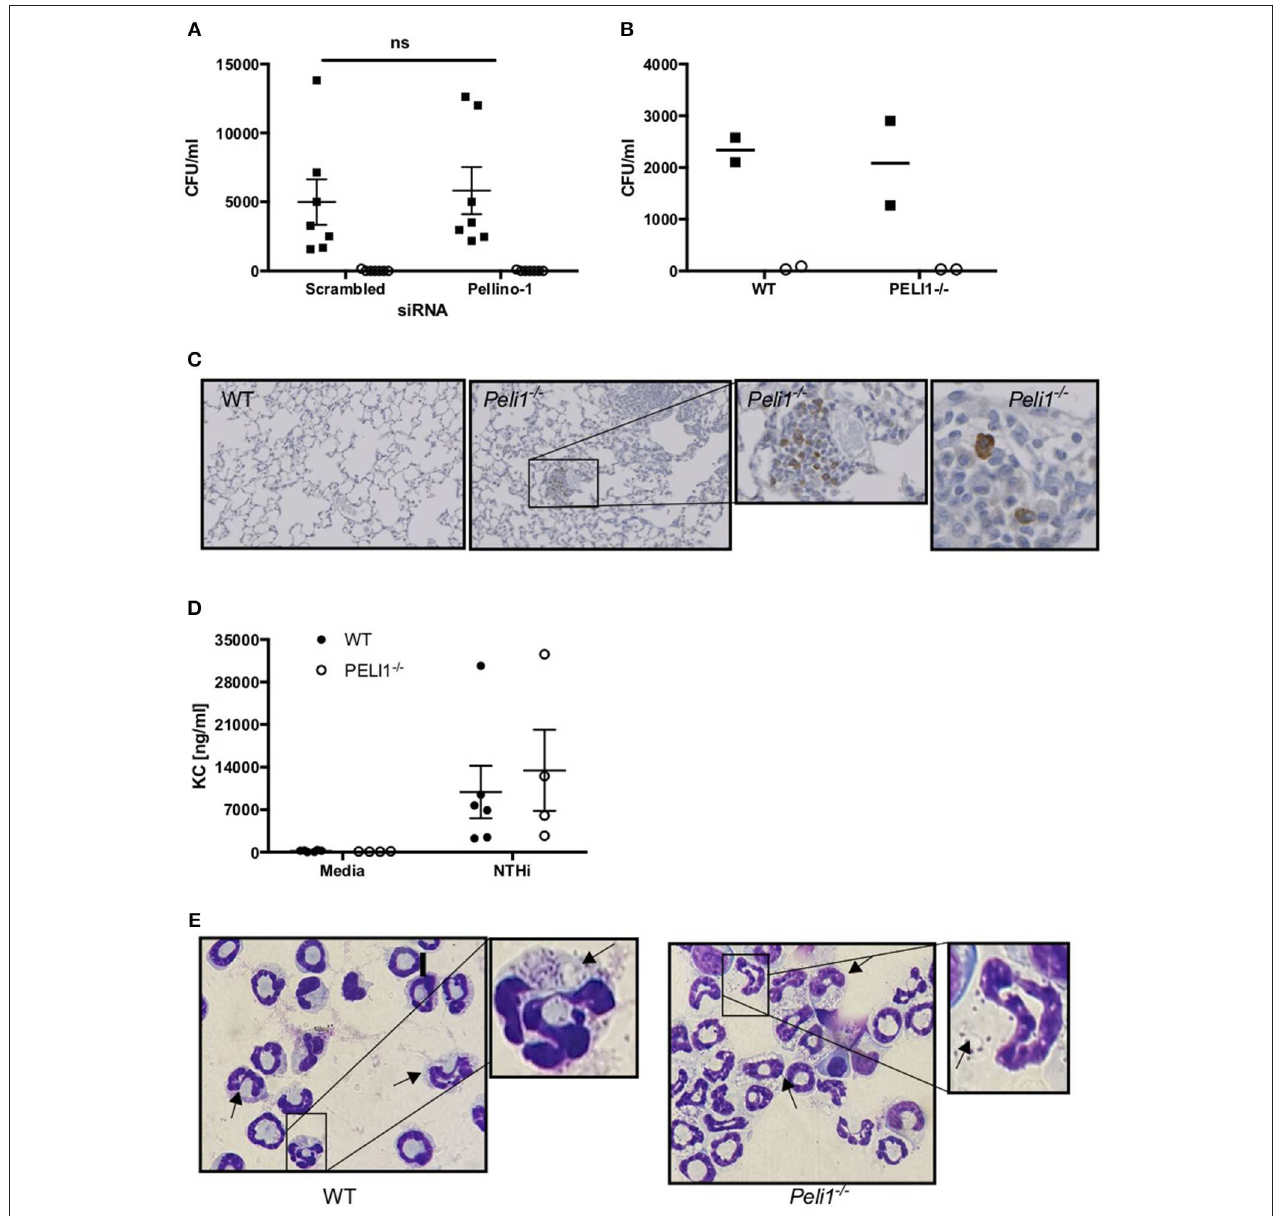
FIGURE 7 | Internalization and killing of NTHi is not impaired by loss of Pellino-1. (A) MDMs were transfected with siRNA targeting Pellino-1 or scrambled siRNA (control). 48h following transfection, MDMs were infected with NTHi (MOI 10) for 2h after which cells were lysed and viable intracellular bacteria enumerated by Miles Misra (2h, black squares). In parallel wells, MDMs were treated with gentamycin to kill extracellular bacteria for a further 2h, after which intracellular NTHi were enumerated by Miles Misra (4h, open circles). (B) WT and Peli1 − / − BMDM were infected with NTHi (MOI 5) and viable bacteria enumerated at 2 and 4h as above. (C) Lung sections from WT and Peli1 − / − mice treated with LPS/Elastase were subjected to histology and immunostained for KC. Zoomed inset shows individual cells staining for KC in brown. (D) Day 14 WT and Peli1 − / − BMDM were infected with NTHi (MOI 5) for 24h and cell free supernatants subjected to KC ELISA. (E) neutrophils were isolated from WT and Peli1 − / − BMDM and infected with NTHi (MOI 10) for 1h. Cytocentrifuge slides were prepared and arrows point to neutrophils containing NTHi. Zoomed inset highlights NTHi within intracellular vacuoles. Data are expressed as individual points with mean ± SEM ( A , n = 7) or mean ( B , n = 2) or as bars ( C , mean ± SEM, n = 3–5).